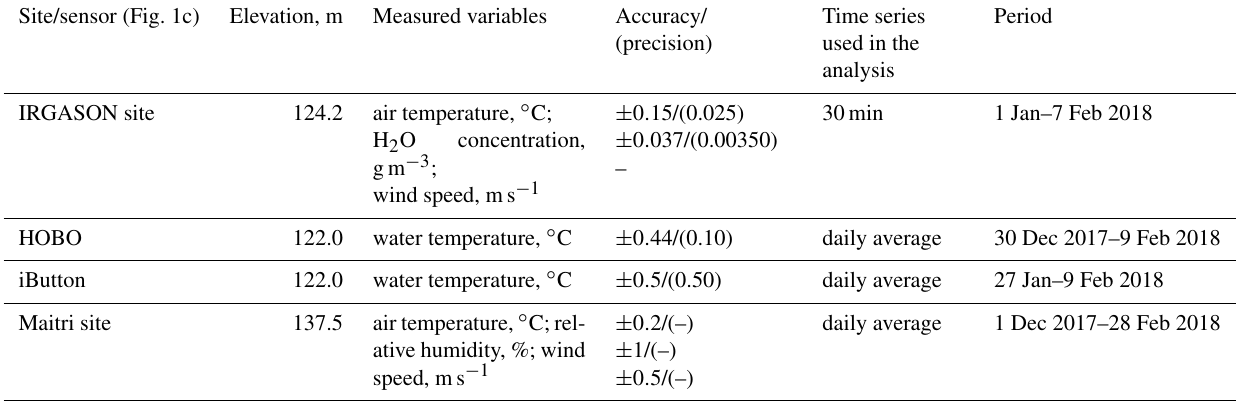
Table 2. The hydrological and meteorological data collected during the field experiment in the summer 2017/18: “–” no information available. Site/sensor (Fig. 1c) Elevation, m Measured variables Accuracy/ IRGASON site 124.2